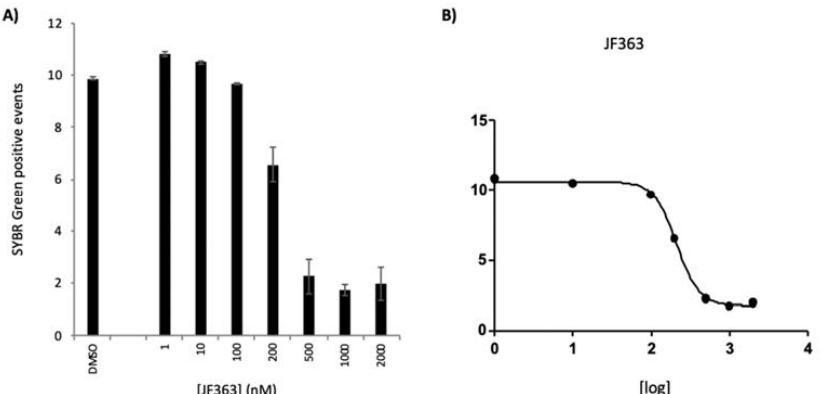
Figure 2. The dose-dependent activity of JF363 against P. falciparum erythrocytic infection in vitro. ( A ) Percentage of P. falciparum -infected red blood cells in the presence of different concentrations of JF363 or the drug vehicle, DMSO. A ring stage synchronized culture (~1% parasitemia) of P. falciparum NF54 was incubated for 48 h with increasing concentrations of JF363 (1, 10, 100, 200, 500, 1000, and 2000 nM), and a percentage of DMSO, the drug vehicle control, equivalent to that present in the highest compound concentration was employed as a negative control. Results are expressed as mean ± SD. ( B ) Dose–response curve. A representative experiment out of 3 independent biological replicates.